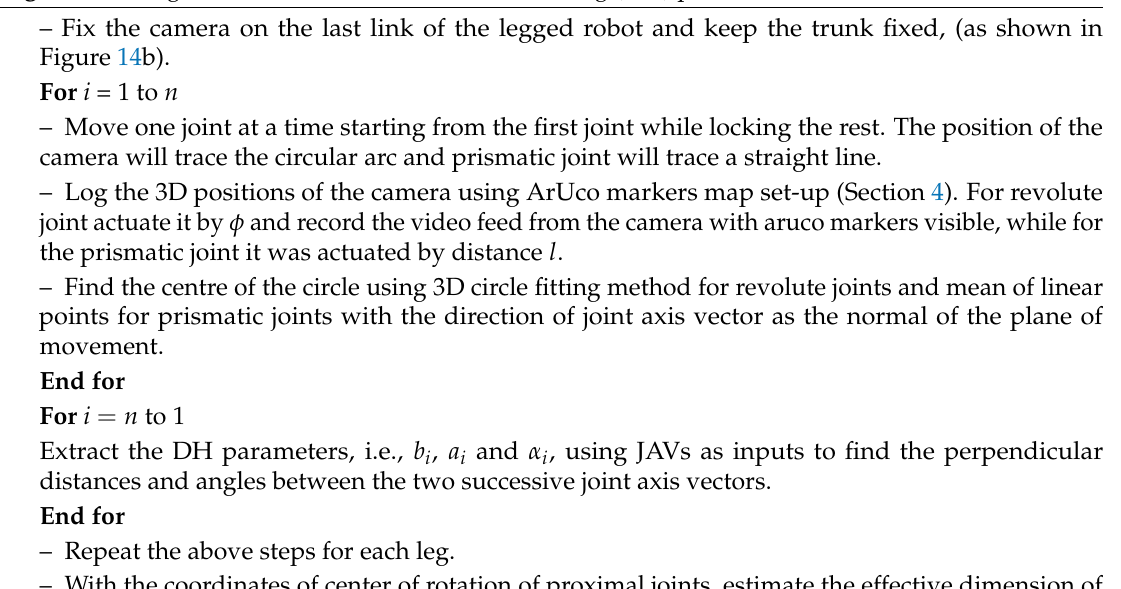
Algorithm 1 Algorithm to find the Denavit–Hartenberg (DH)